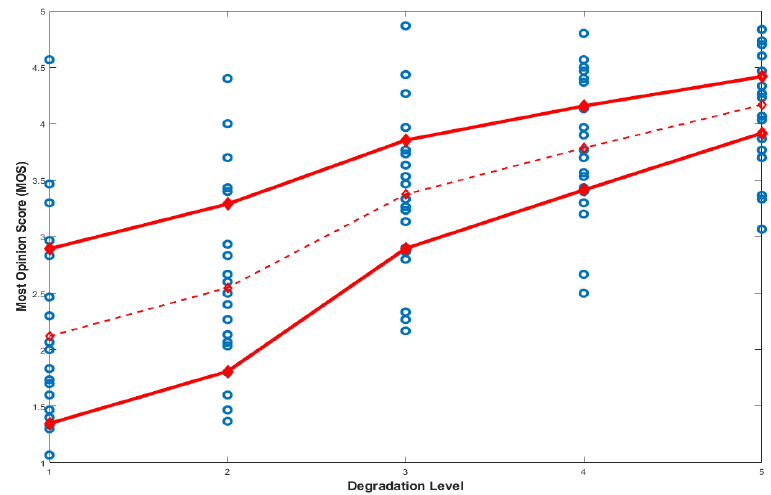
Figure 17. Scatter plot of MOS obtained for J2K noise. Expected Score v s MOS obtained from all Degradation